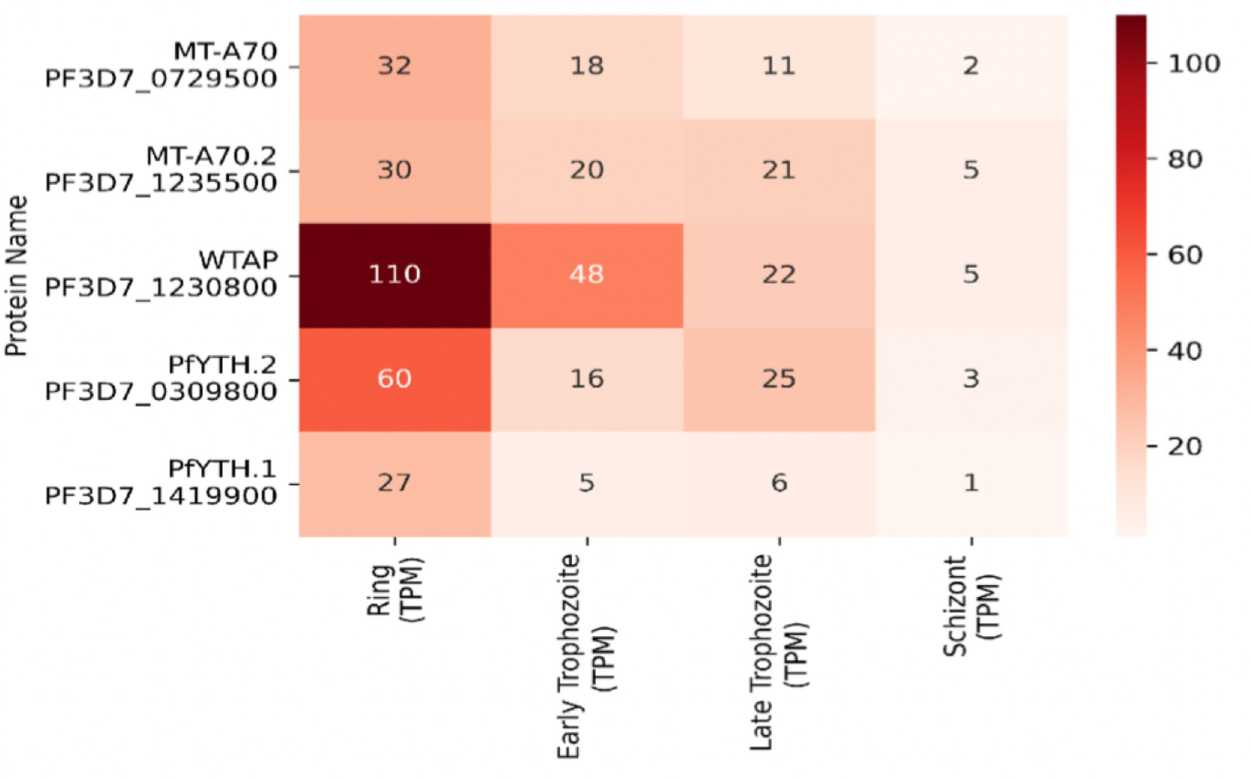
Fig 4. Heat map representation of transcript abundance of the m 6 A writer and reader proteins, MT-A70, MT-A70.2, WTAP, PfYTH.2 and PfYTH.1 in P . falciparum asexual RBC cycle derived from transcriptomic data (Plasmodb.org) [184]. TPM, transcripts per million.